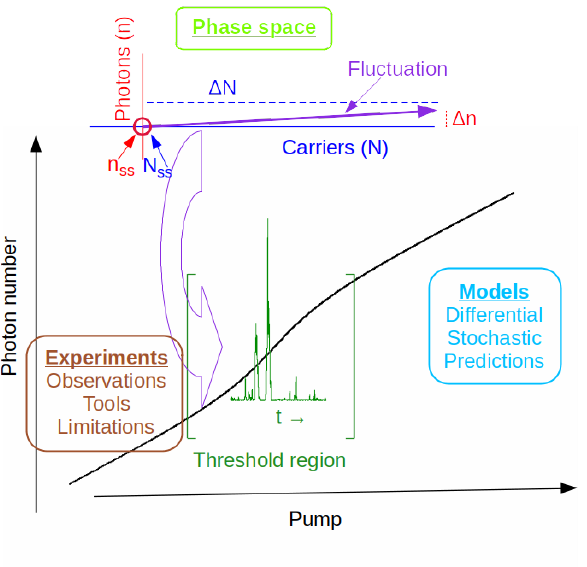
Figure 1. Graphical representation of the topics addressed in the manuscript. N ss and n ss refer to the steady-state operation values of the population inversion and photon number, respectively, around which a fluctuations operates, for a given set of